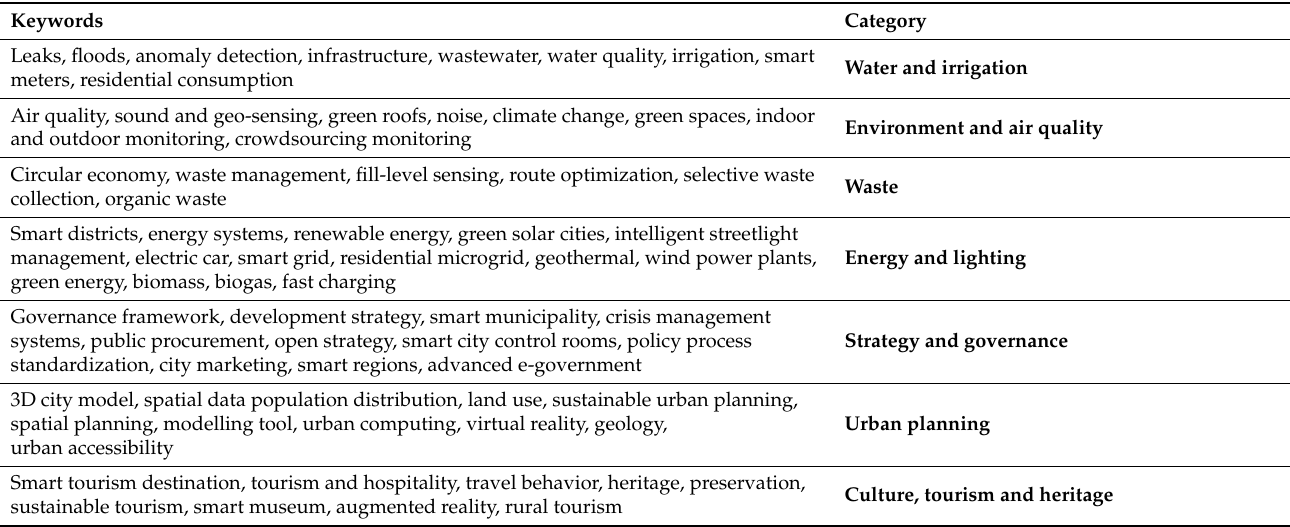
Table 1. Inductive analysis and originating keywords of smart city